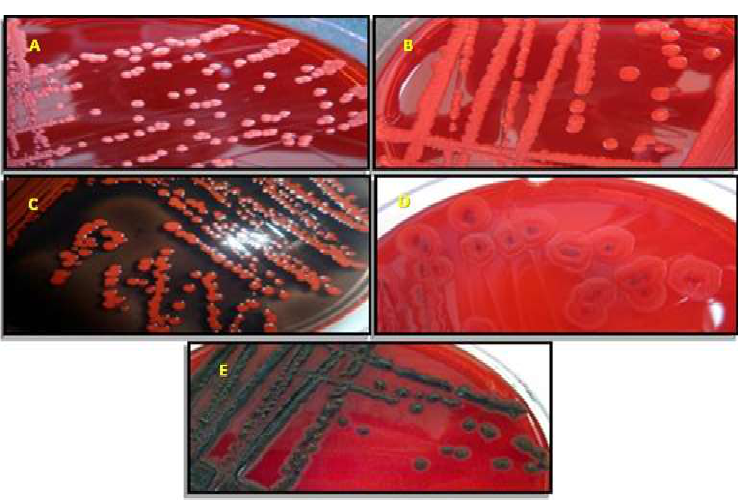
Figure 2. Different morphotypes obtained on Congo red agar based on the color obtained. ( A ): Pink, Figure 2. Di ff erent morphotypes obtained on Congo red agar based on the color obtained. ( A ) Pink, ( B ) ( B ): red, ( C ): Bordeaux, ( D ): red colonies with dark center, and ( E ): black colonies. red, ( C ) Bordeaux, ( D ) red colonies with dark center, and ( E ) black